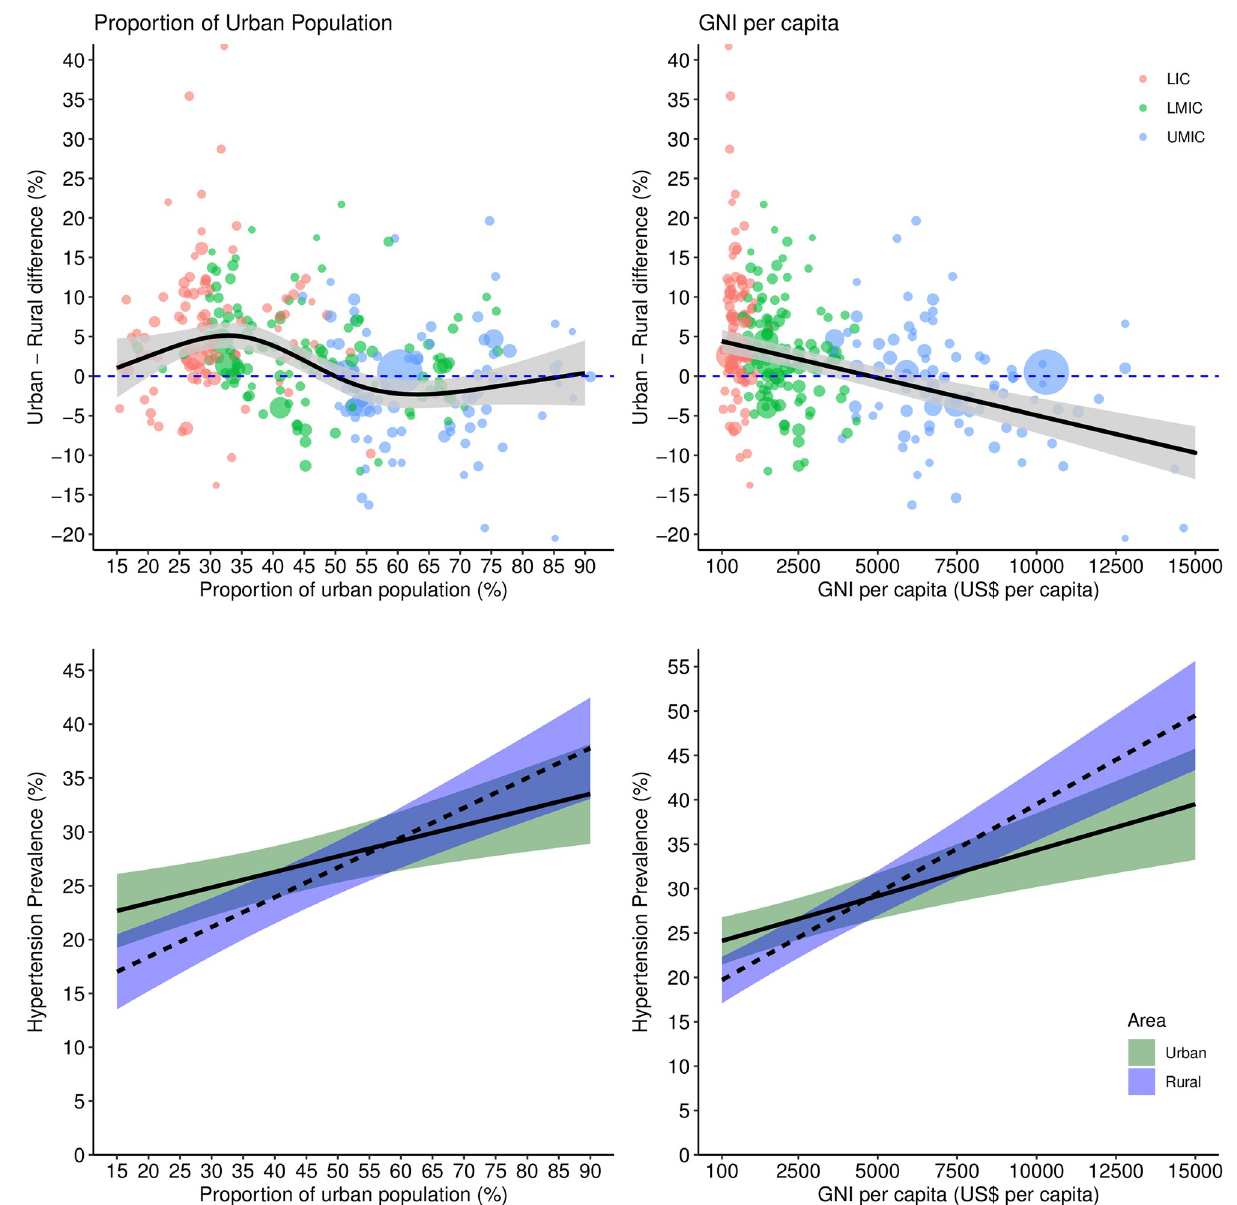
Fig 4. Urban-rural difference in hypertension prevalence and prevalence of hypertension in urban and rural areas according to proportion of urban population and GNI per capita. Predicted urban-rural differences and prevalence from meta-regression models with proportion of urban population or GNI per capita, and 5 study-level features: use of population groups to define urban and rural areas, number of blood pressure readings, sampling bias, detection bias (urban/rural), and prevalence adjusted by age/sex/sampling weights. The plot shows the prediction (marginal mean from models 9 and 11) of this model varying proportion of urban population from 15% to 90% and GNI per capita from $100 to $15,000 (range from observed data) and setting the 5 study-level features to the least biased category (no use of groups, � 2 readings, probably low risk of sampling bias, probably low risk of detection bias (urban/rural), and adjusted prevalence). Income country status is only to illustrate each survey, and it is not adjusted in the model. Shaded areas represent 95% confidence interval and circle sizes proportional to inverse of variance. In the bottom panel, the solid lines represent urban areas and dashed lines represent rural areas. GNI, gross national income; LIC, low-income country; LMIC, lower-middle-income country; UMIC, upper-middle-income country.